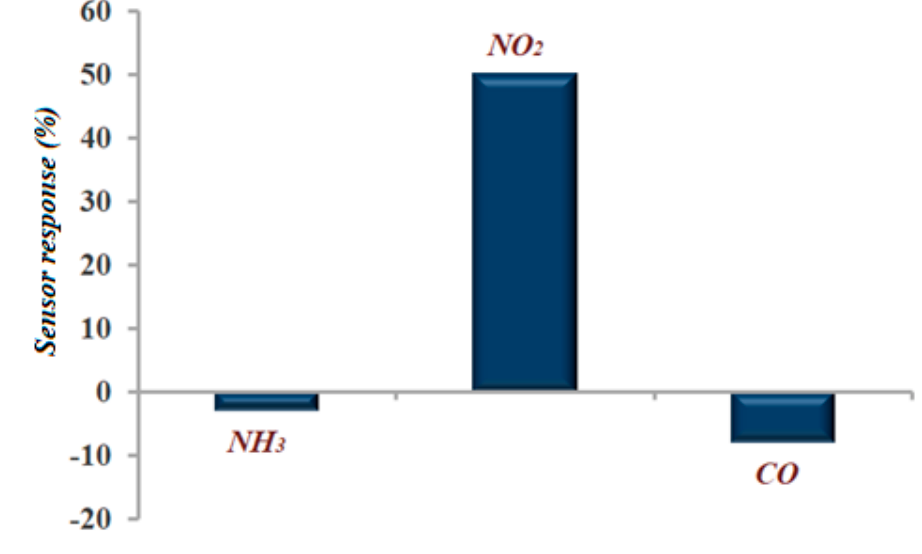
Figure 7. Selectivity of the sensor.